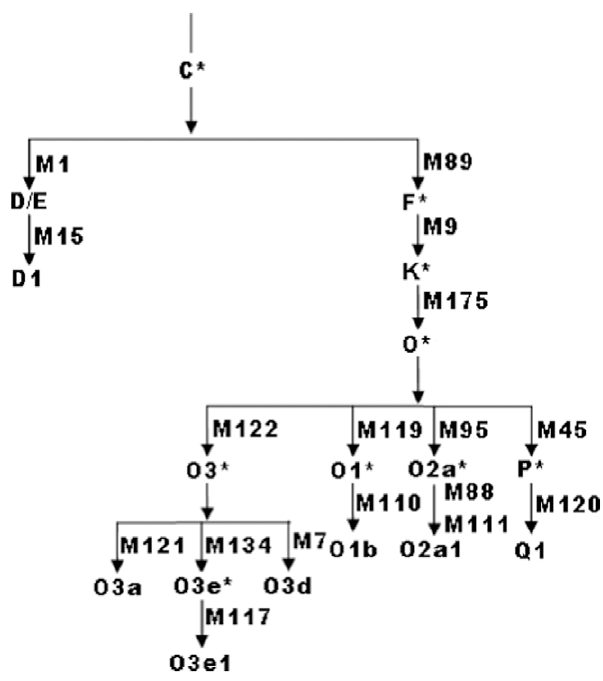
Figure 8. Phylogenetic diagram of 17 haplogroups. This diagram defined by 16 Y chromosome biallelic markers drawn according to the NRY haplogroup tree of East Asia (shown in reference 34). The most recent markers defining the haplogroups are beside the